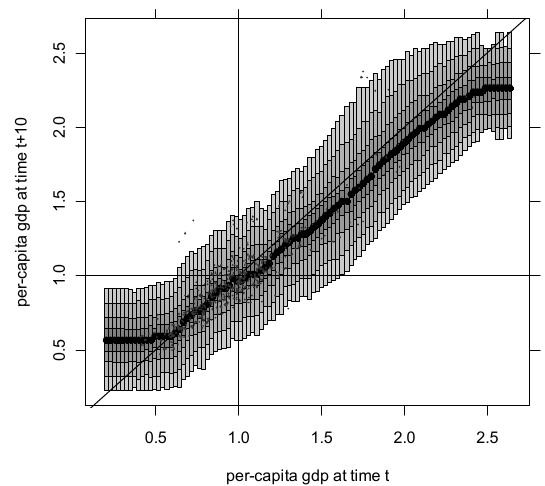
Figure A3 – Intra-Distribution Dynamics of regional per-capita income in Europe. HDR plot of conditional density for transitions of 20 years between 1980-2002. Groningen is ex- cluded from the sample. Estimates are based on a kernel density estimator with a variable bandwidth in the x direction (span = 0.15), a fixed bandwidth in the y direction (b = 0.224) and a mean function specified by a lowess smoother (span = 0.15).